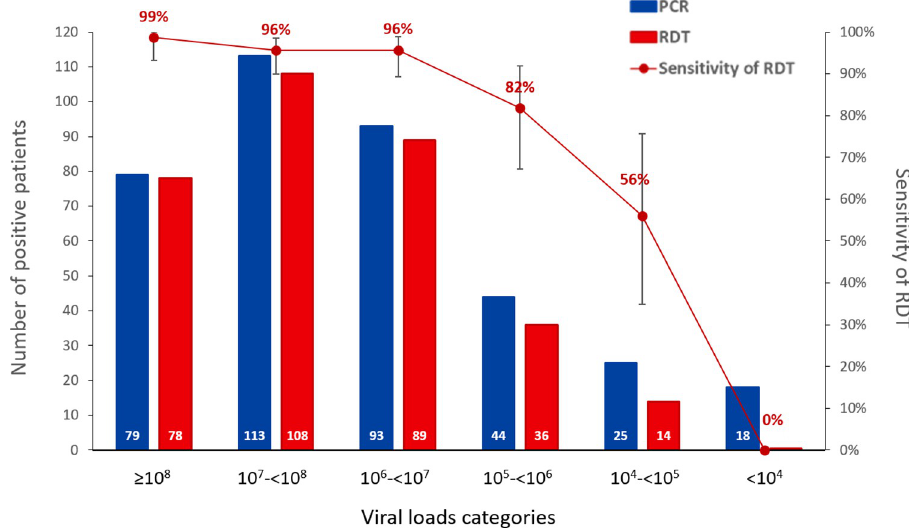
Fig 4. Number of patients positive by RDT (in red) and nasopharyngeal PCR (in blue) and sensitivity of RDT according to viral load categories.